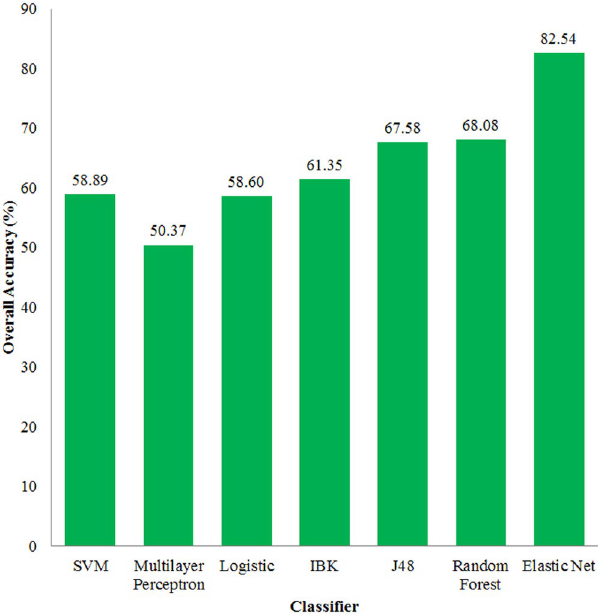
Figure 6. The comparison results of the Elastic Net with other